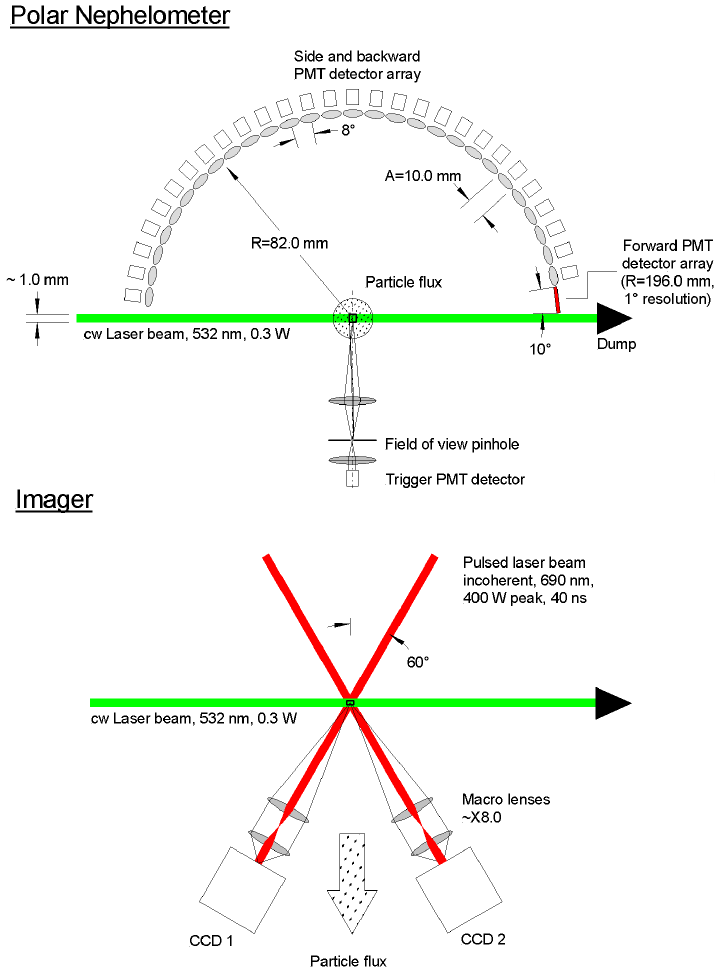
Figure 1. Schematic diagram of the two main components of PHIPS-HALO. The scattering plane of the polar nephelometer (upper diagram) is oriented at 90 ◦ to stereo imager (lower diagram). Note that the forward PMT detector array is no longer used. Figure adapted from Stegmann et al.